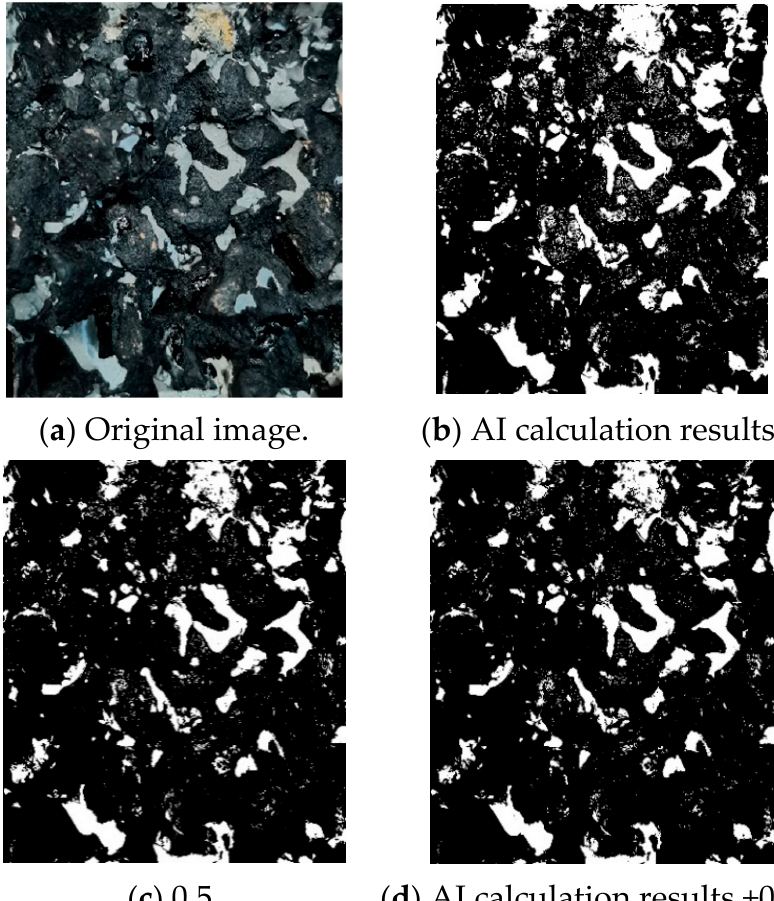
Figure 2. Selection of image binarization threshold.